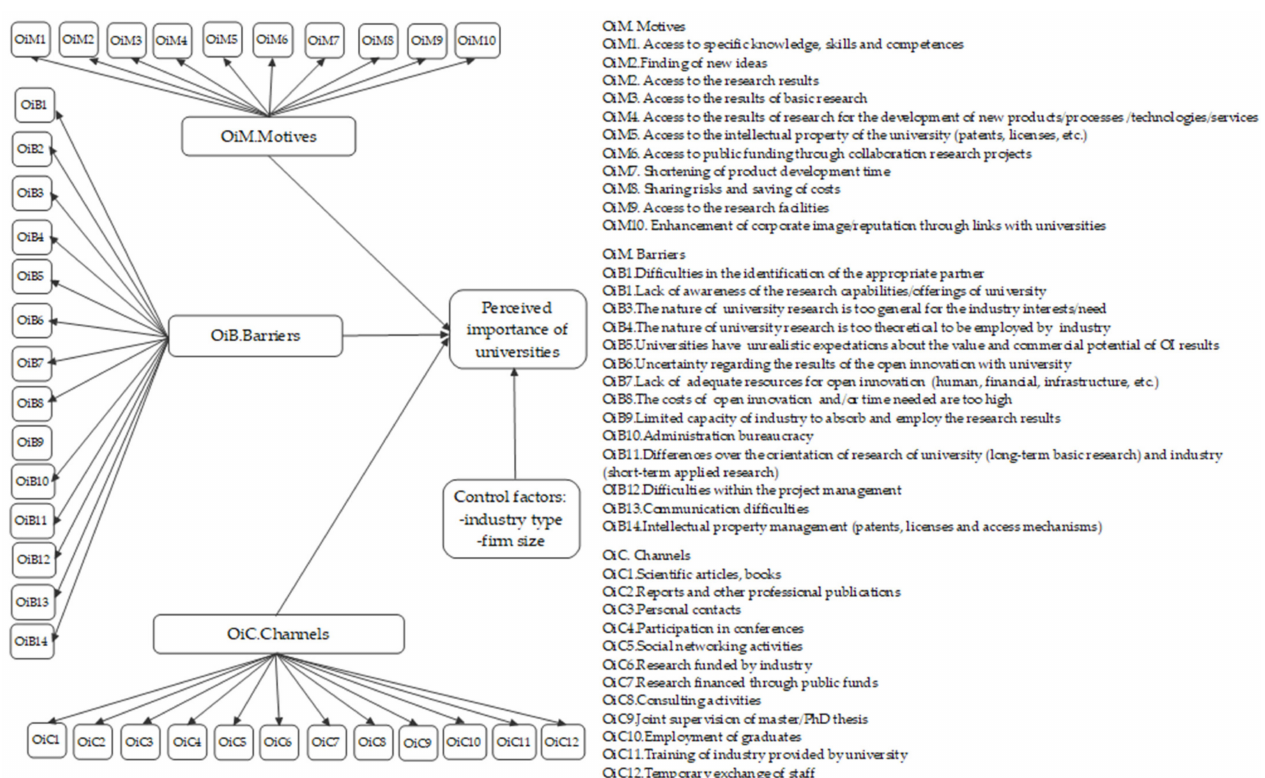
Figure 2. Research framework